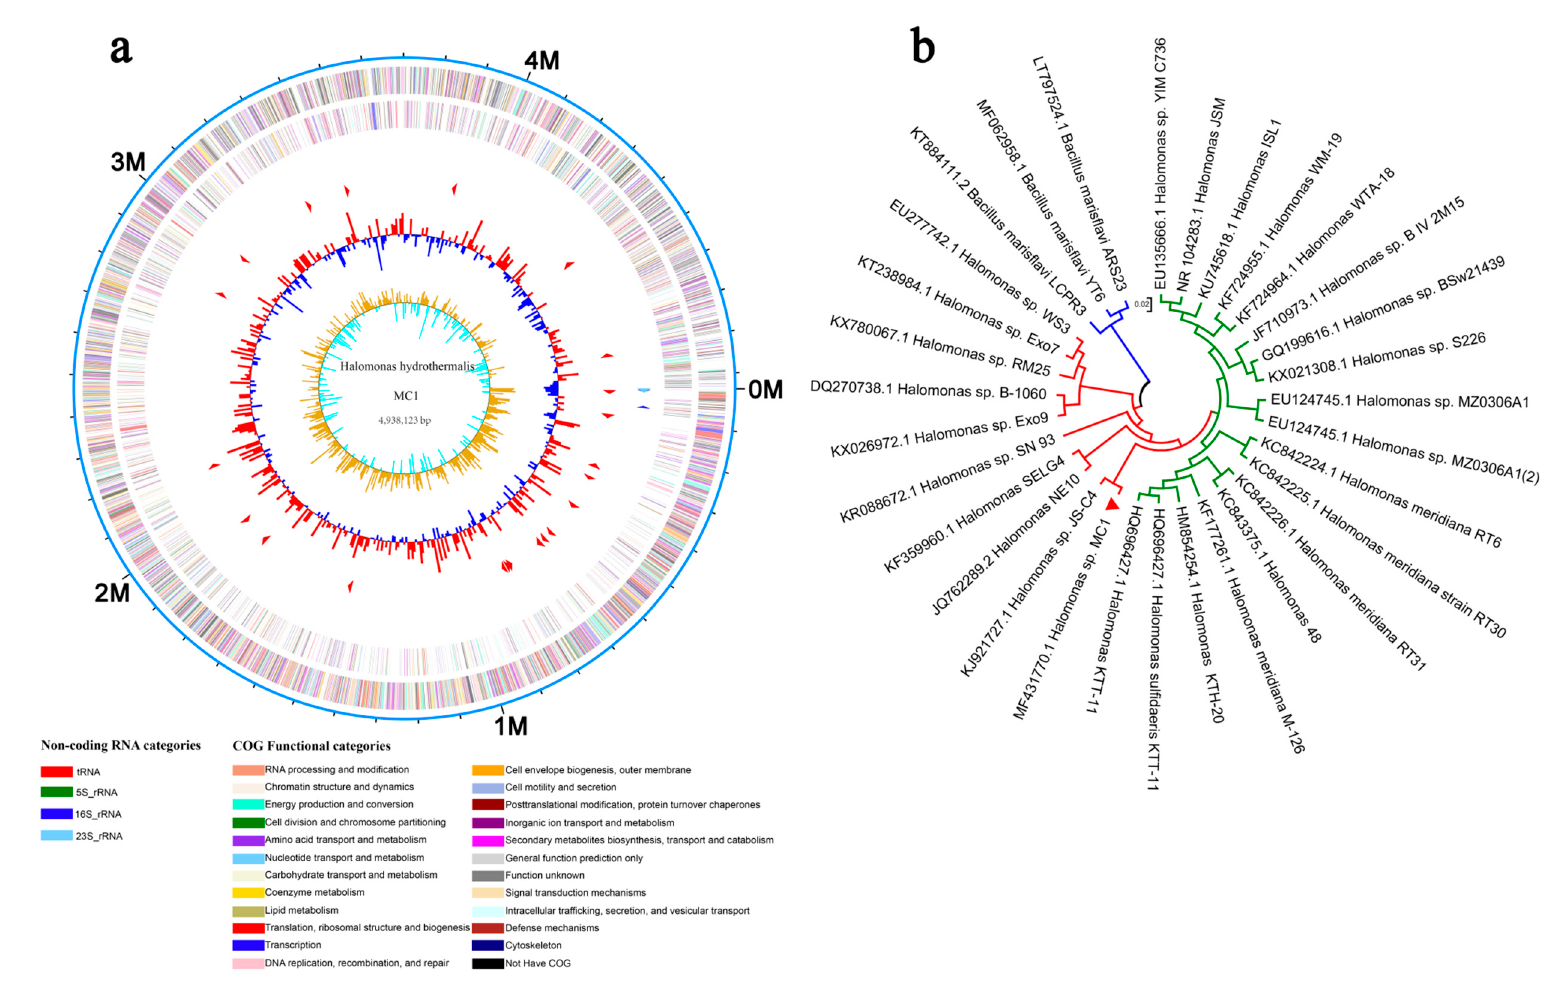
Figure 1. Genome-wide assessment. ( a ) Circular plot of reads mapped to the Halomonas sp. MC1 genome. ( b ) Phylogenetic tree constructed on the basis of 16S rDNA sequences of neighboring species using the neighbor-joining method. The bars represent 0.02 substitutions per nucleotide position.